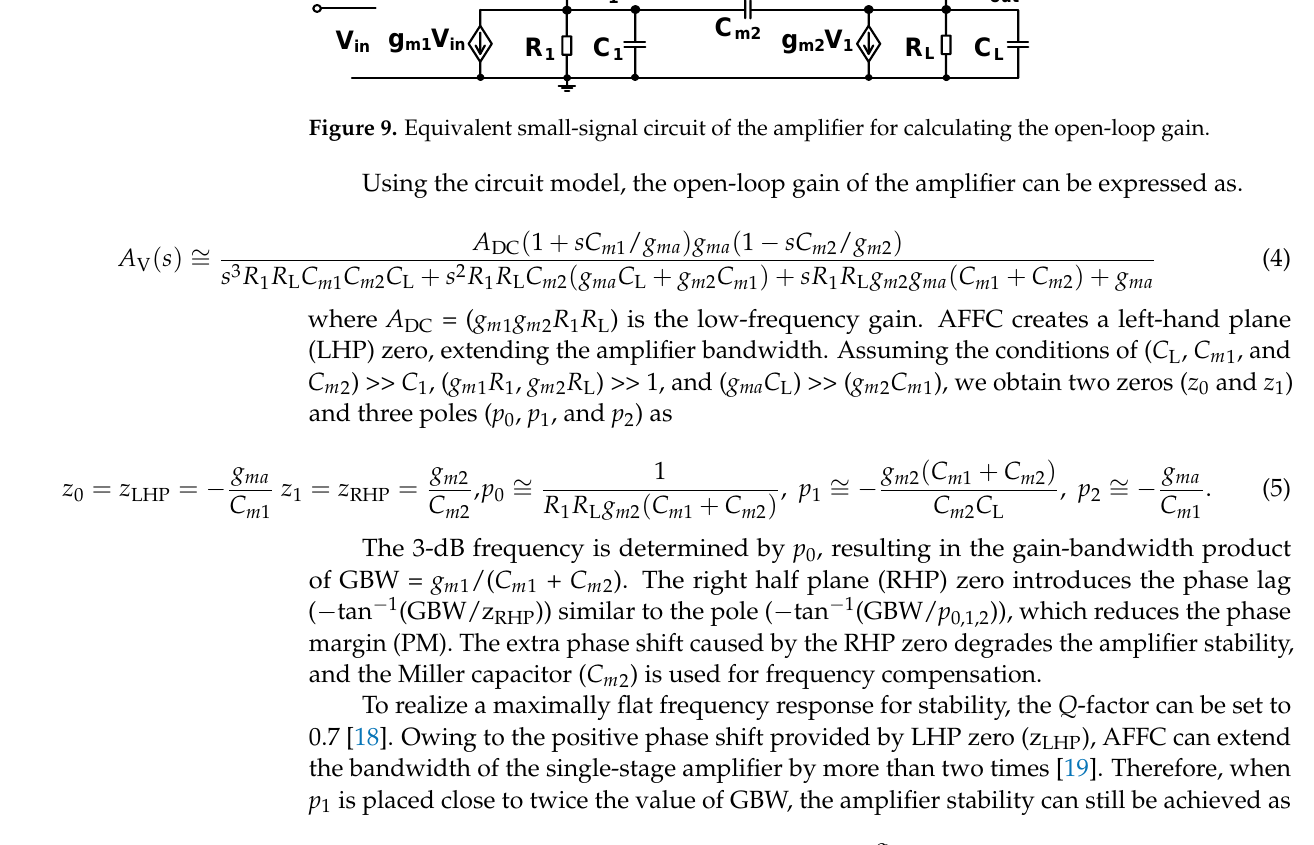
2 μ / 1 μ Figure 8. Schematic of the folded-cascode amplifier with common-mode feedback.